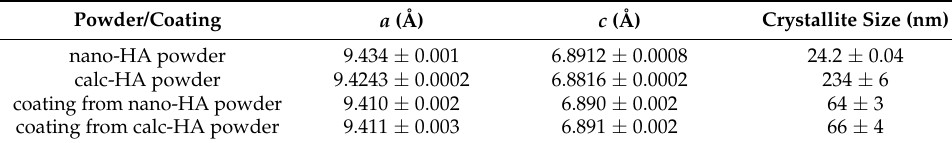
Table 1. Structural parameters of the HA phase in powders and coatings.